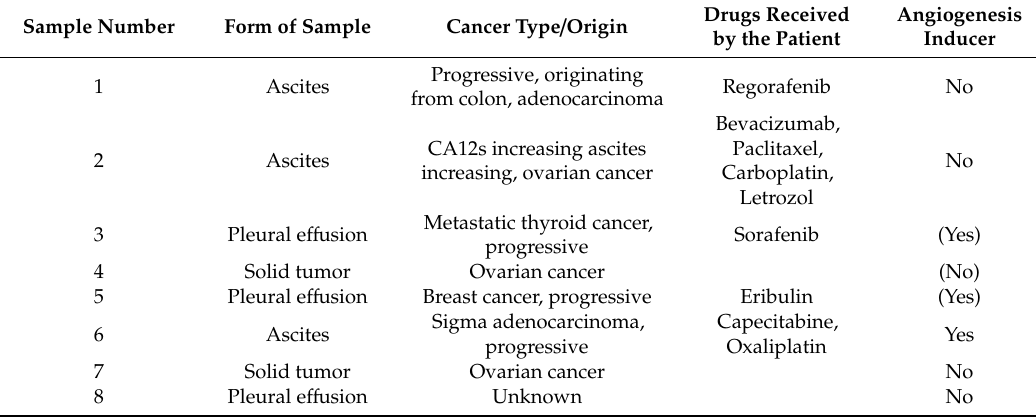
Table 2. Characteristics of the samples received from patients and results obtained from the angiogenic-induction potential test. Those samples which di ff er only mildly from control are marked in